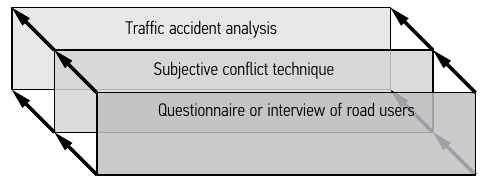
Fig. 1. ‘Overlapping’ danger spots (Vujanić et al. 2009b)